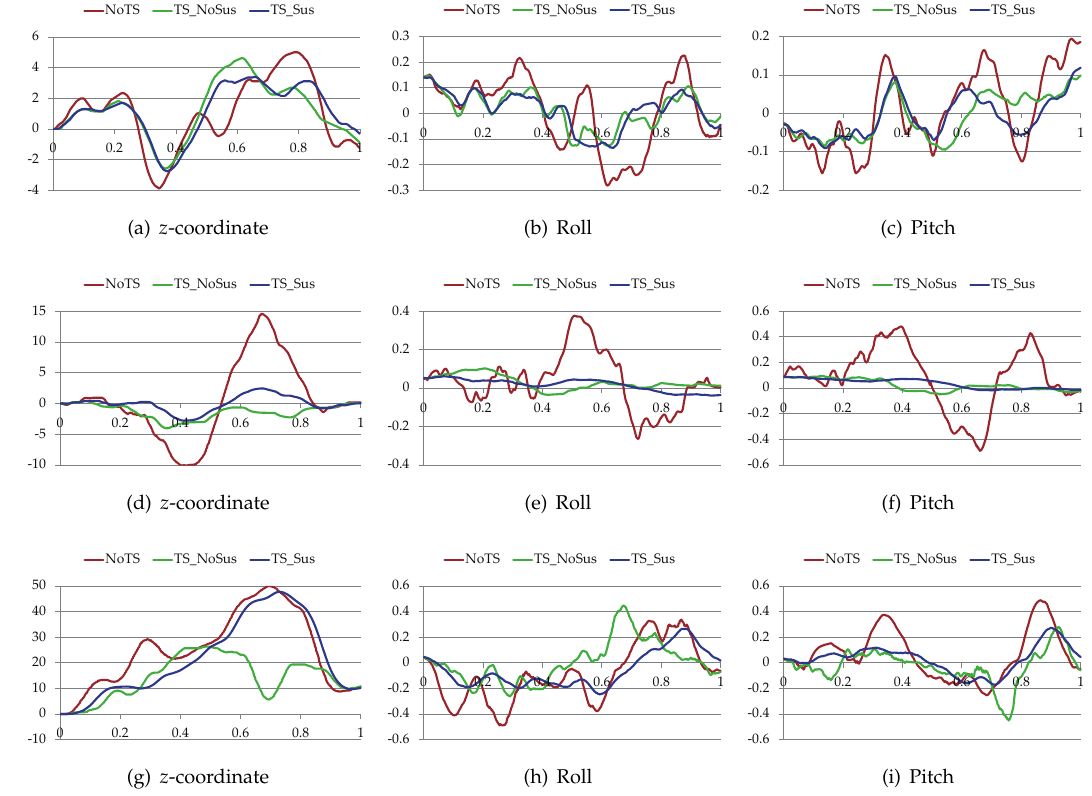
Figure 16. The z -coordinate, the roll and the pitch of the vehicle along the trajectories. ( a – c ) The vehicle state along the trajectories shown in Figure 15a; ( d – f ) The vehicle state along the trajectories shown in Figure 15b; ( g – i ) The vehicle state along the trajectories shown in Figure 15c. Table 5. The performance comparison of the trajectories shown in Figure 15 (averaged over 50 runs). Terrain Surface Shown in Figure